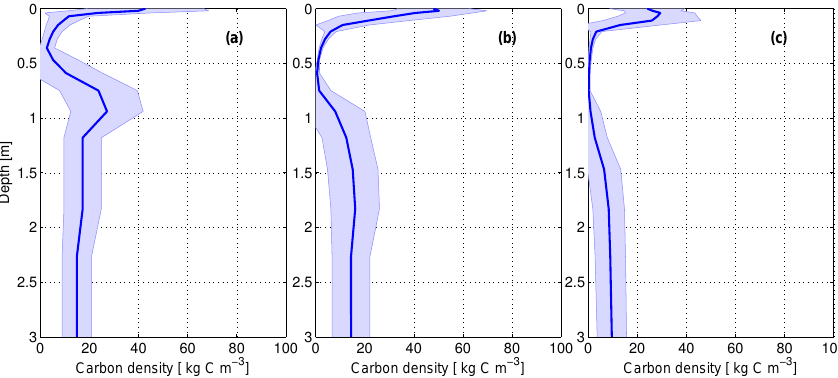
Figure 4. The average soil carbon distribution from 200 grid cells for (a) a tundra region in continuous permafrost zone, (b) boreal forest on the boundary between continuous and discontinuous zones, and (c) low carbon soil at the southern border of the discontinuous permafrost zone. The solid blue curve indicates the mean, and the white blue shading indicates the spread in the simulated soil carbon density.